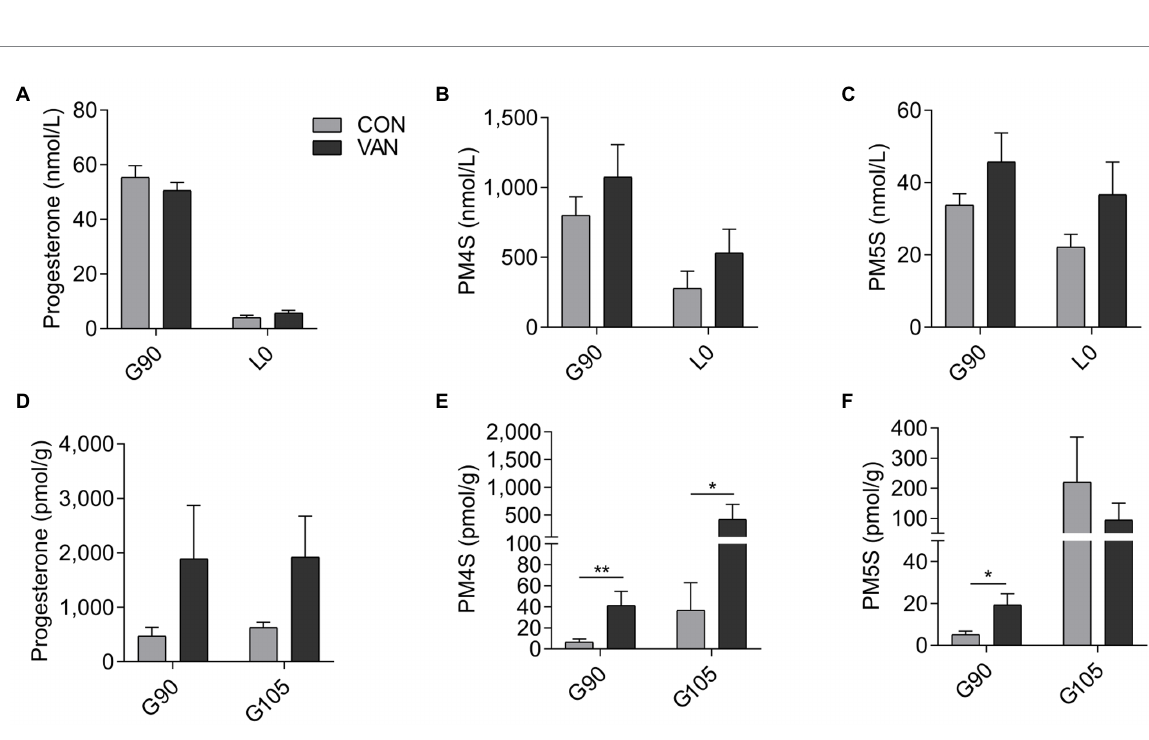
FIGURE 5 The levels of (A) progesterone, (B) PM4S, (C) PM5S in maternal peripheral serum, and (D) progesterone, (E) PM4S and (F) PM5S in feces after VAN administration at G90 and L0. Data are shown as means ± SE, * p < 0.05, ** p <